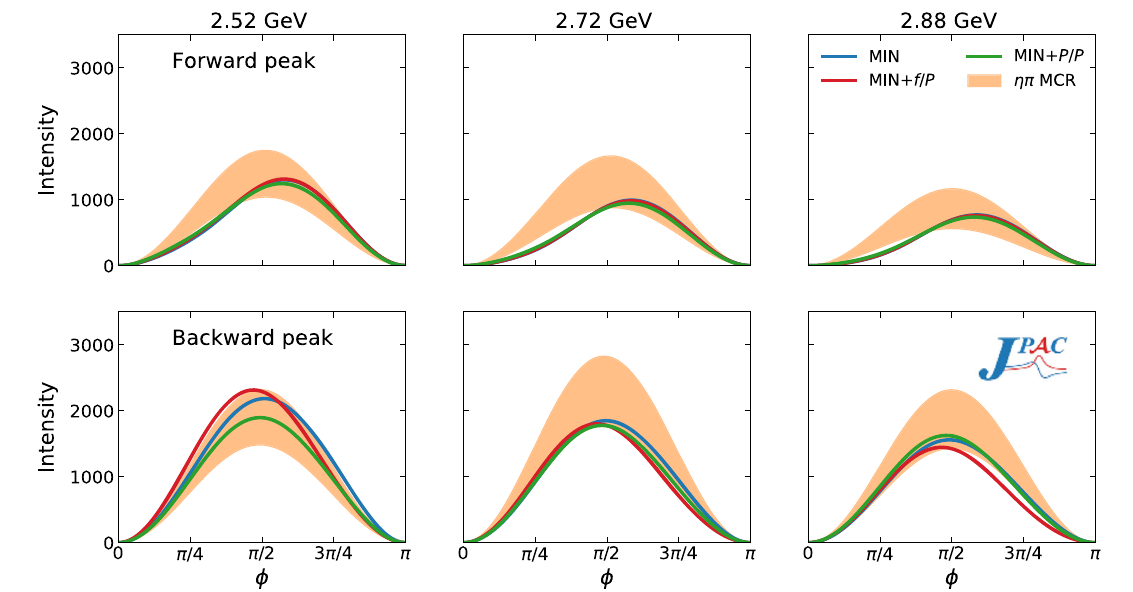
Fig. 15 φ -dependence of the experimental I ( m ηπ ,(cid:4)) from MCR (orange) compared to the MIN (blue), MIN + f / IP (red) and MIN + IP / IP (green) fits. at three fixed energies for cos θ = 0 . 866